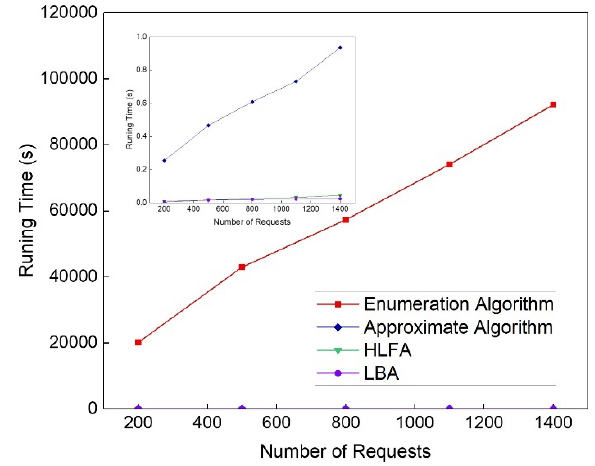
Figure 8. Comparisons of the running time.